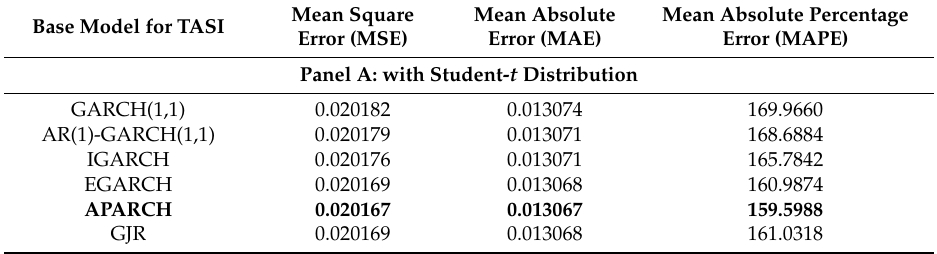
Table 6. Evaluation of one-day out-of-sample volatility forecasts comparison for the TASI after excluding the high volatility periods. The table presents the loss function values for one-day out-of-sample volatility forecasts of TASI. This table is a reproduction of Table 4 after excluding the financial crisis period and Saudi Arabia’s stock collapse period. We used the data from 1 July 2009 to 3 August 2014 to evaluate in-sample data for volatility modeling. This table also presents the forecasting criteria: Mean Square Error (MSE), Mean Absolute Error (MAE), and Mean Absolute Percentage Error (MAPE). Lowest values for the statistics are denoted in bold